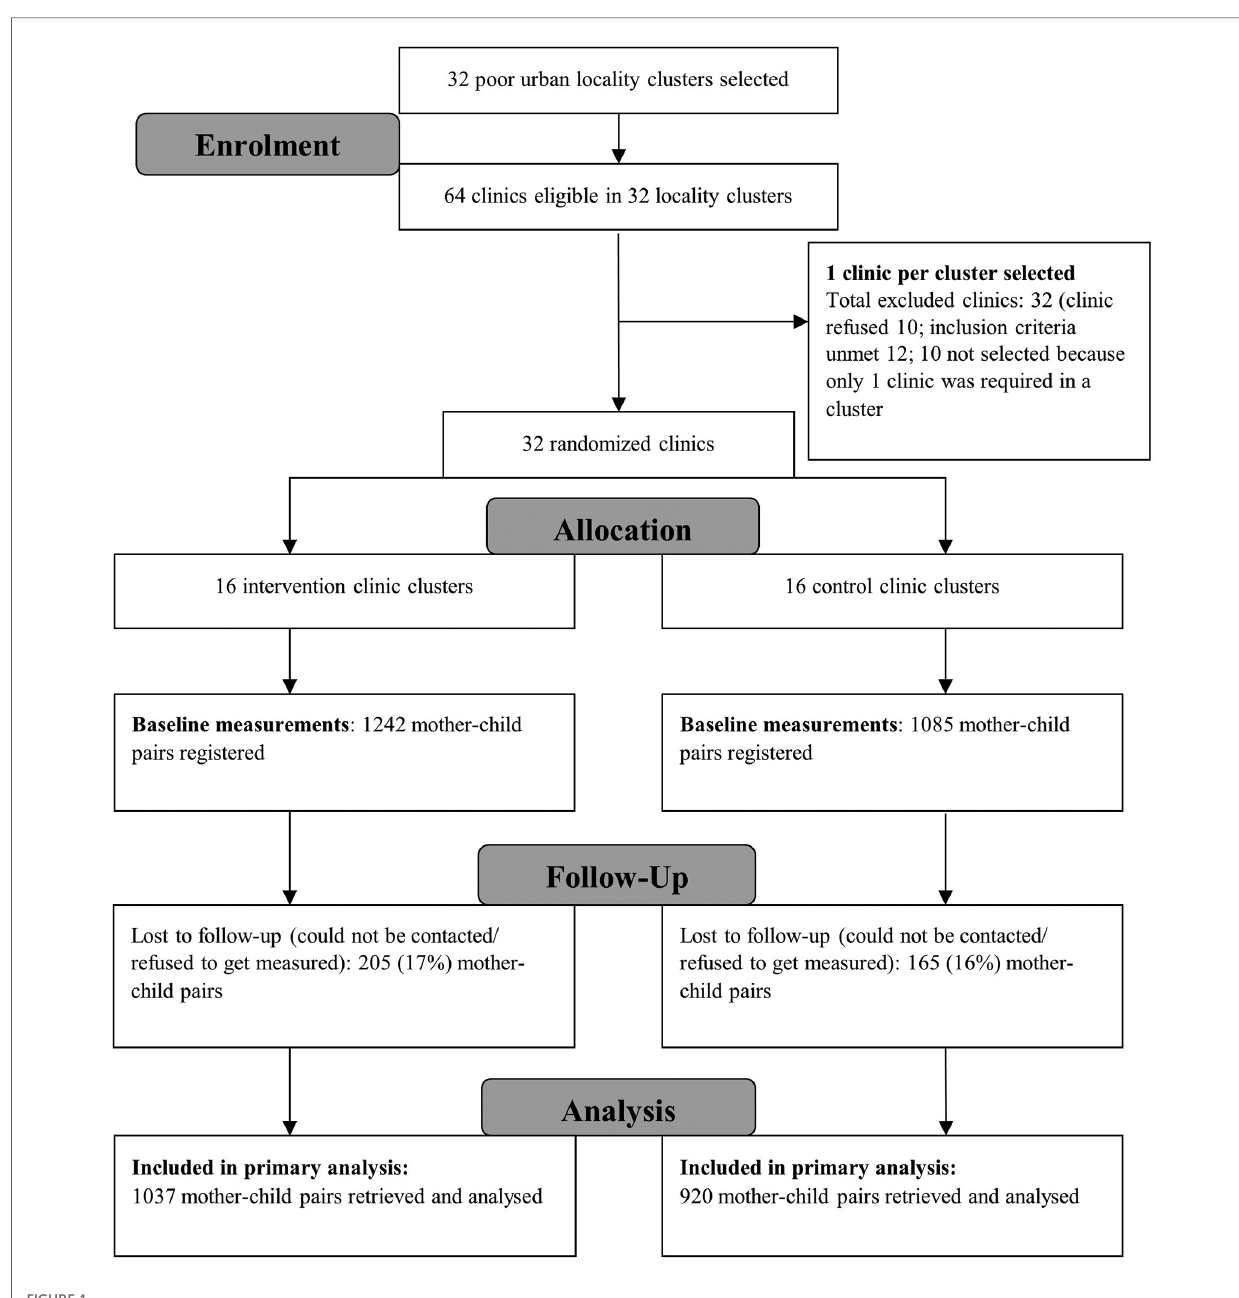
FIGURE 1 CONSORT fl ow diagram of ECD trial (0 – 12 months).* [*Adopted from published trial outcomes (10)]. ECD, early child